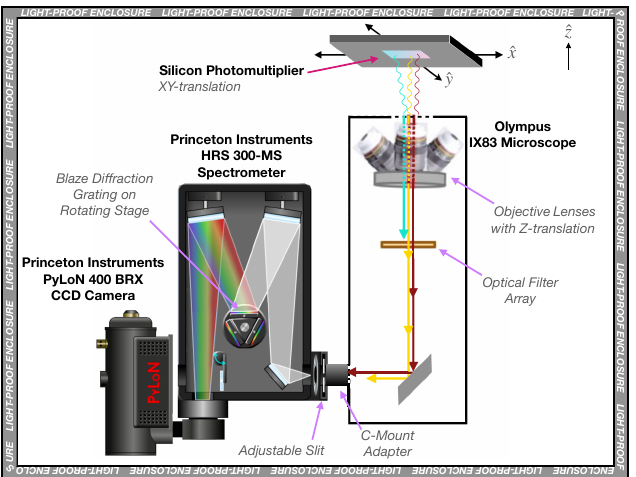
Figure 1. Schematic diagram of the TRIUMF apparatus used for SiPM imaging and spectroscopic